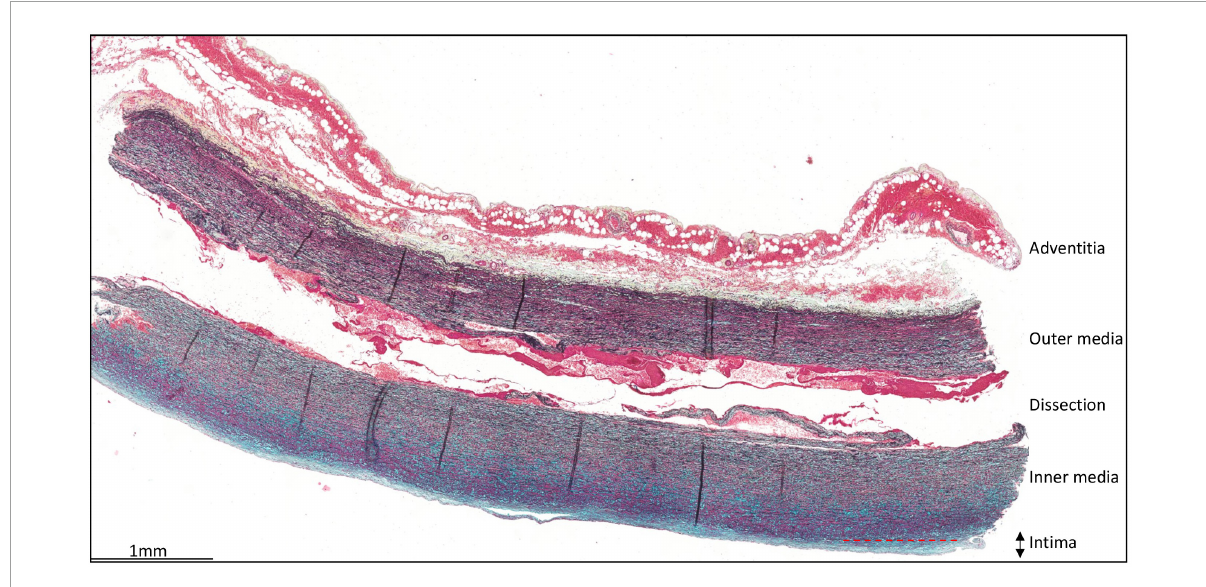
FIGURE1 Transverse histologic section (4 µ m) of a type A aortic dissection aortic specimen. The vessel wall layers are indicated: adventitia, media, and intima. The intimal layer is defined as the area between the endothelial cells lining the luminal surface and the lamina elastica interna. Scale bar shown in